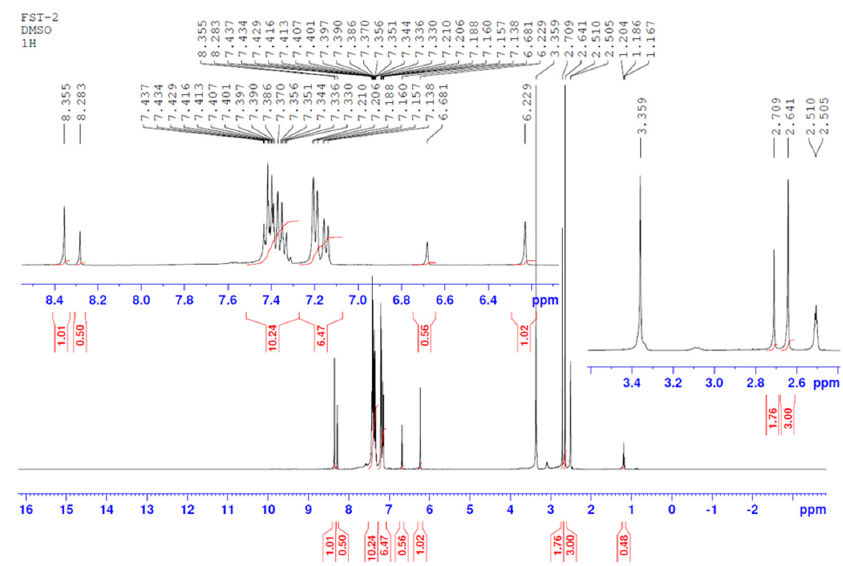
◦ C. Figure 1. The 1 H NMR spectrum (400 MHz) of BHFA-NMe in DMSO-d 6 at 20 °C. 6 at 20